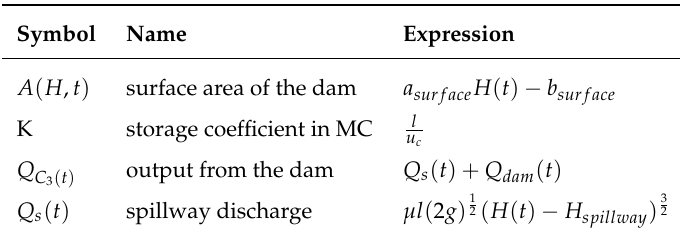
Table 5. Expression table associated with the EPN representation in Figure